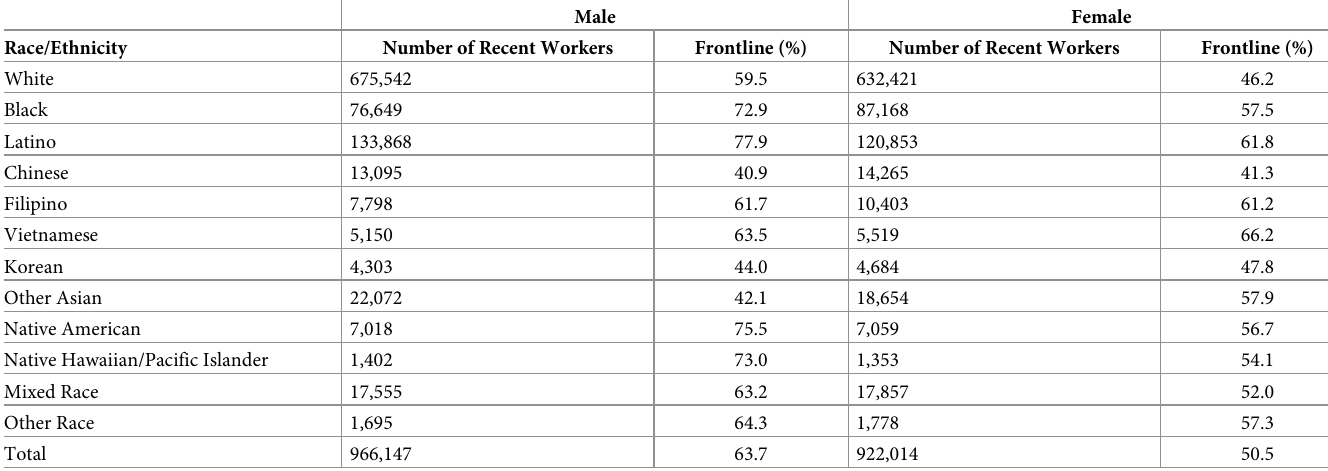
Table 1. Number of recent workers and percentage in frontline occupations by race/ethnicity and